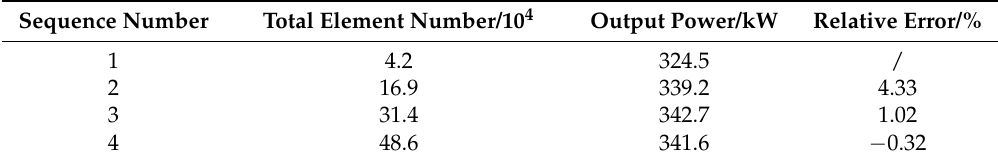
Table 3. Result of mesh independence test.